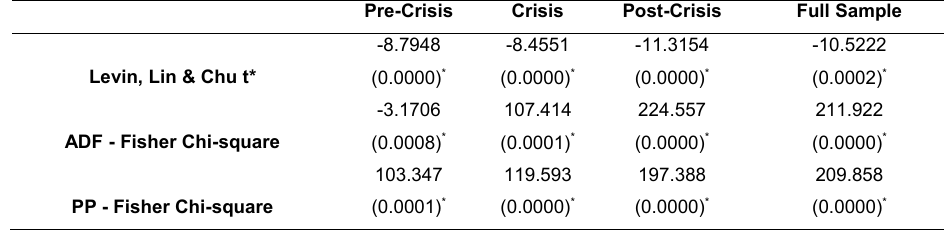
* represents a significance level of 0.05.